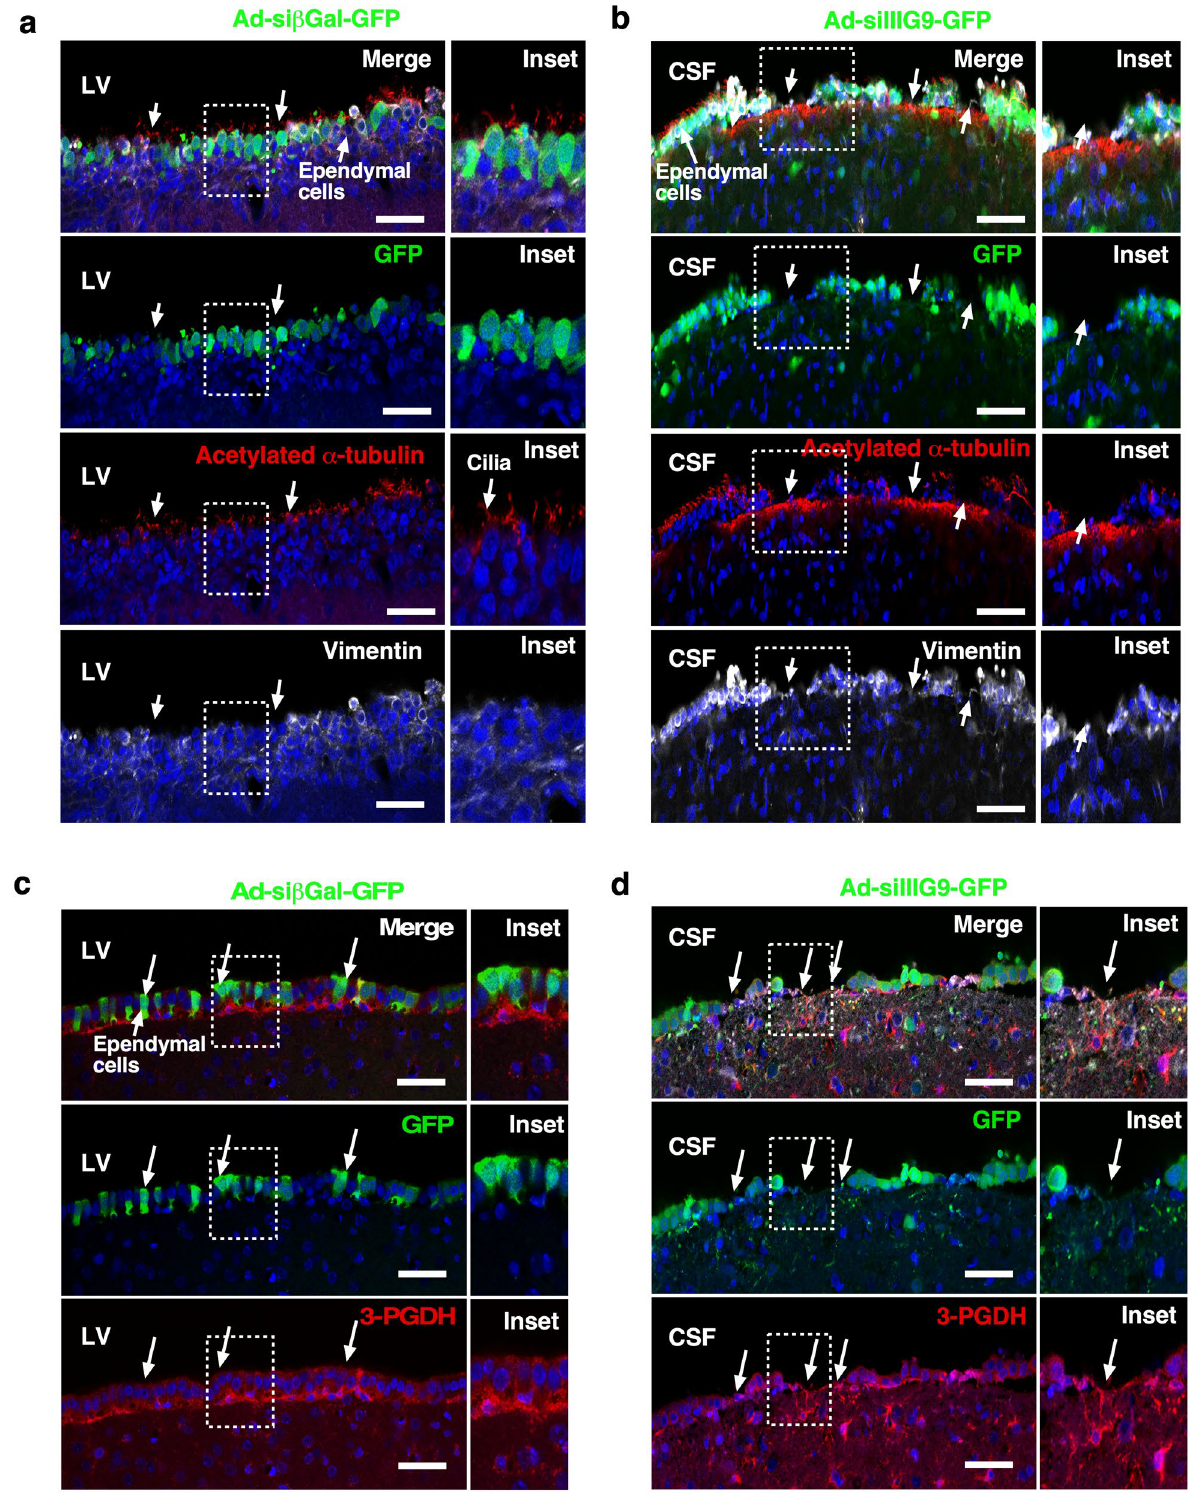
Figure 3. Loss of IIIG9 function in lateral ventricle ependymal cells induces cellular denudation but not astrogliosis. ( a ) Ad-sibGal-GFP expression and immunohistochemistry analysis. Intact ependymal cell layer expressing GFP, acetylated α-tubulin (cilia-red channel) and vimentin (white channel, arrows and insets). The expression of 3-PGDH was also analyzed, and no astrogliosis was detected ( c , arrows). The 3-PGDH signal was mainly detected in subependymal astrocytes. Scale bar = 40 μm. ( b ) Ad-siIIIG9-GFP expression and immunohistochemical analysis. Irregular ependymal cell layer with expression of GFP, acetylated α-tubulin (cilia-red channel) and vimentin (white channel, arrows and insets). The expression of 3-PGDH was also analyzed, and no astrogliosis was detected ( d , arrows). 3-PGDH signal was preserved in subependymal astrocytes. All images are representative of different biologically independent samples. CSF cerebrospinal fluid, LV lateral ventricle. ( a – d ) n = 4. Scale bar = 40